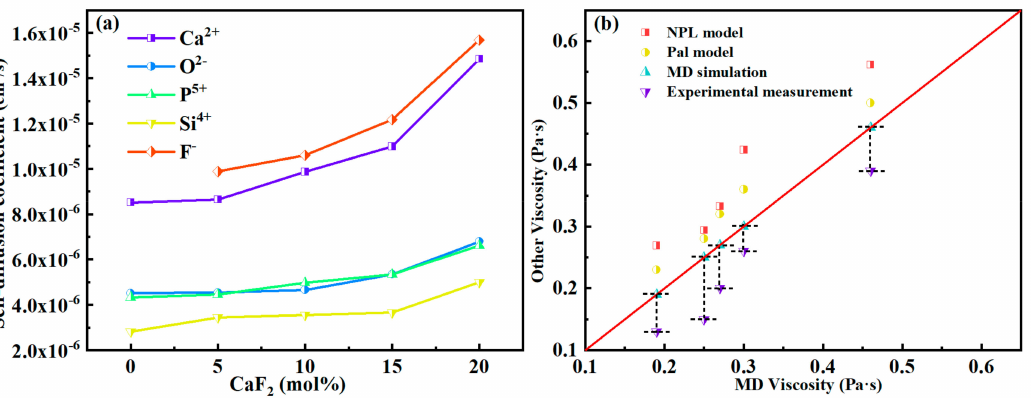
Figure 6. ( a ) The self-diffusion coefficient of each atom with different CaF 2 contents. ( b ) Viscosity comparison of MD simulation, models, and experimental